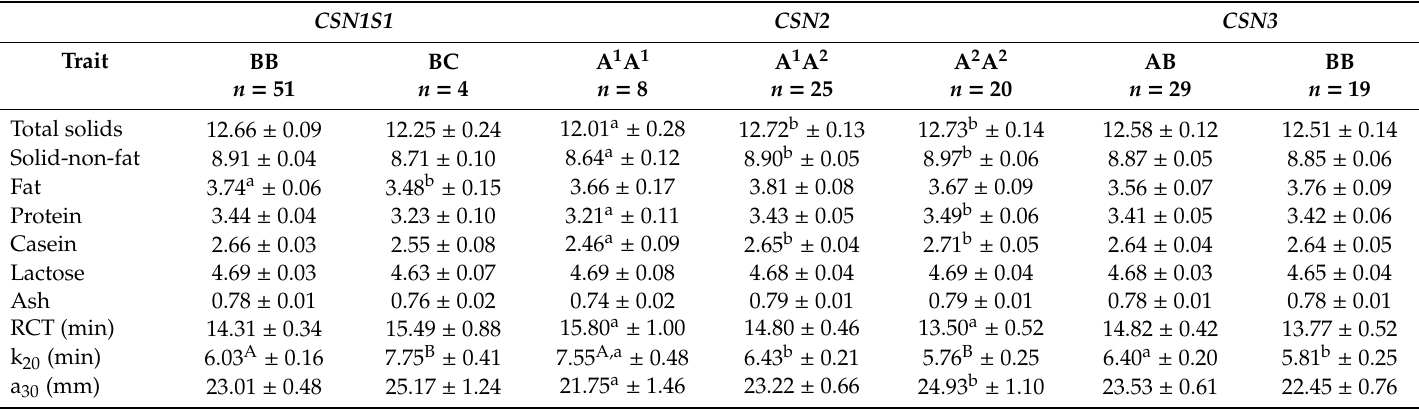
Table 3. Chemical composition (g / 100 g) and MCP of Agerolese cattle milk according to the genotype at CSN1S1 , CSN2 and CSN3